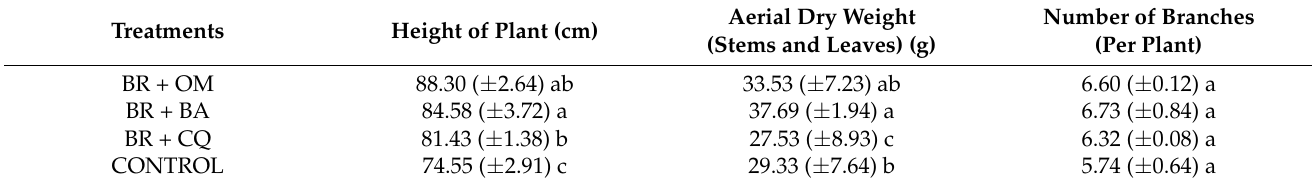
differences (value